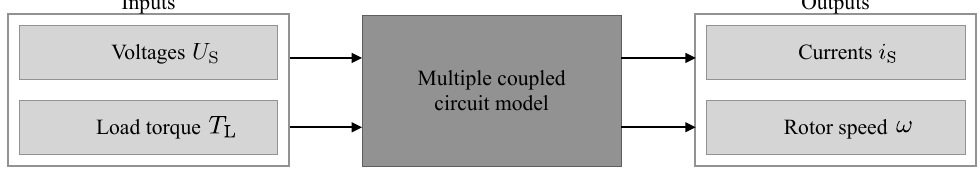
Figure 4. Structure of multiple coupled circuit modeling with inputs (voltages U S and load torque T L ) and outputs (stator currents i S and rotor speed ω